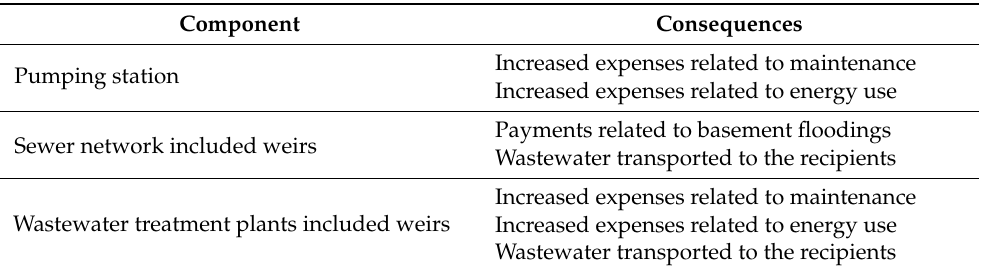
Table 1. Potential unwanted consequences of infiltration and inflow of non-sewer water to the wastewater network (I/I-water) in wastewater